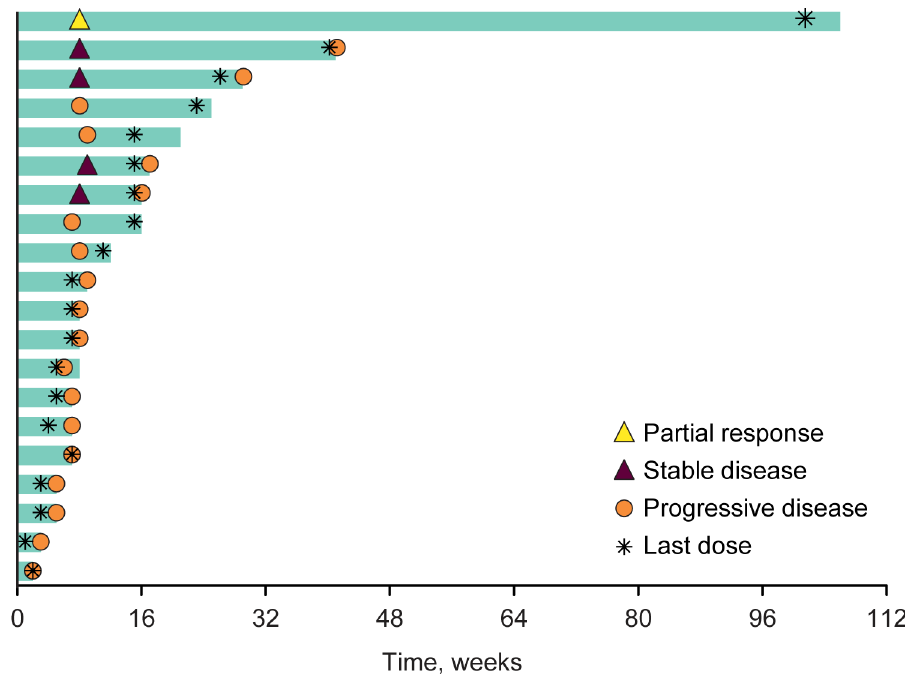
Fig 2. Treatment exposure and response duration. Includespatients evaluablefor best overall response per Response EvaluationCriteria in Solid Tumors version1.1 by investigatorreview ( n = 20). The length of each bar represents the time to the last